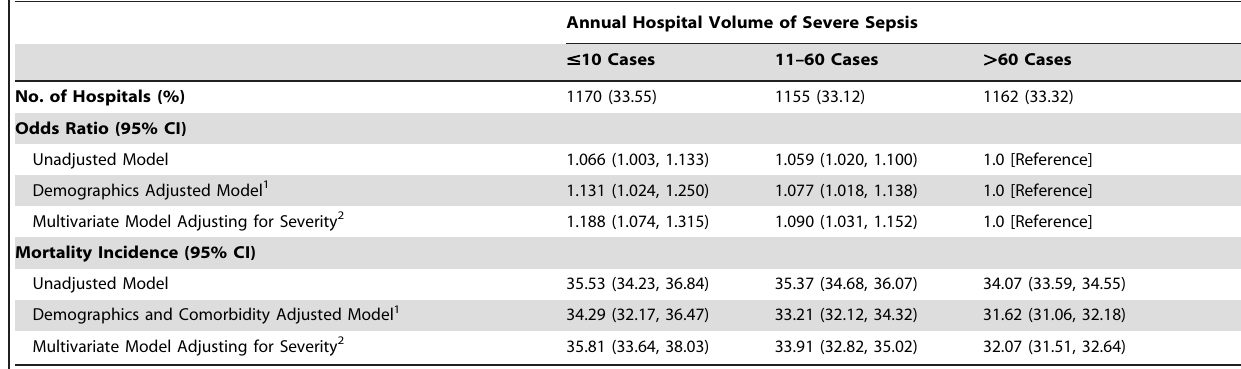
Table 3. Association between Hospital Volume and Risk-Adjusted